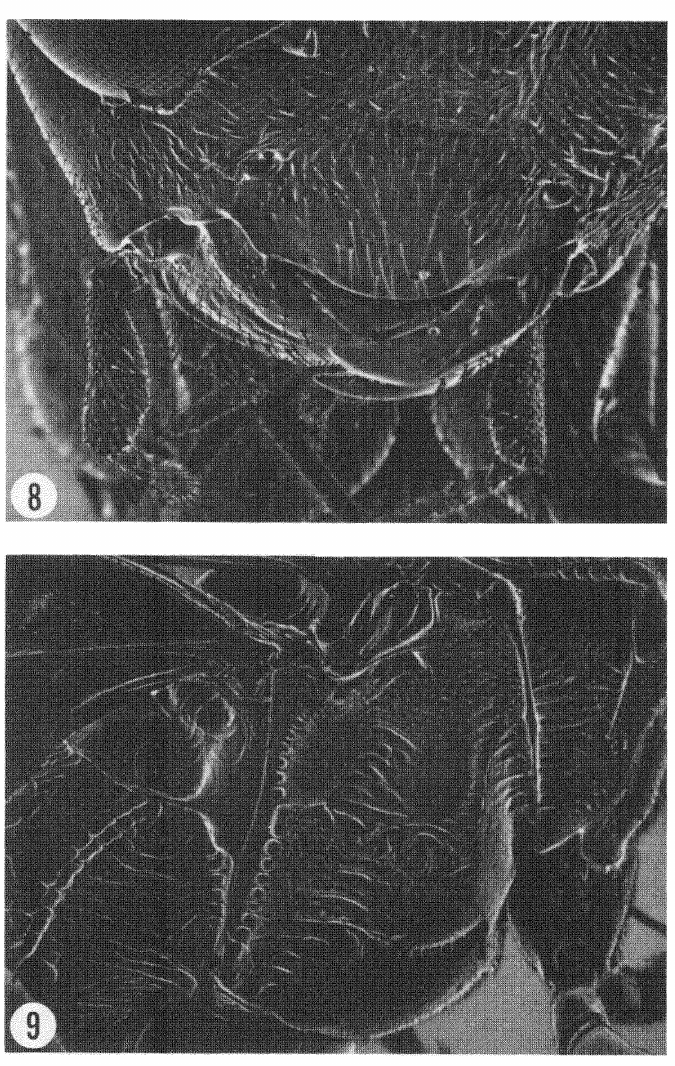
.. SEM Photograph (110), showing clypeus Fig. 8. Cosmiocryptus diplatys, and adjacent areas in anterior view. Fig. 9. Cosmiocryptus diplatys, 9. SEM Photograph (35X), showing greater part of mesosoma in lateral